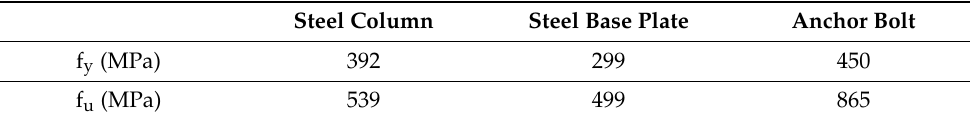
Table 1. Yielding and ultimate stresses used in the FE analysis [21].